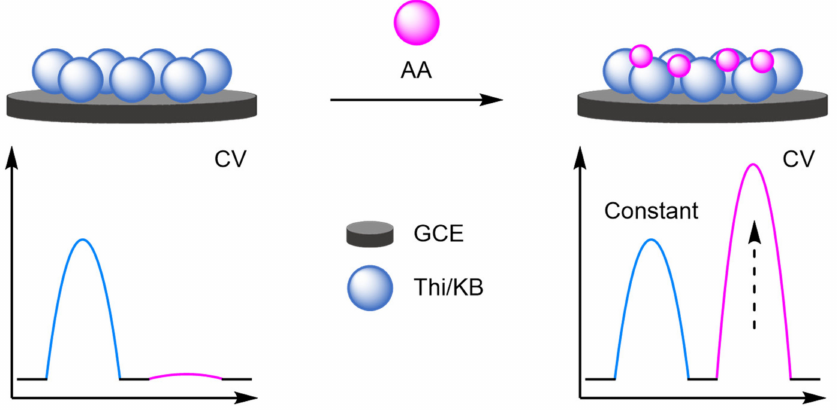
Figure 44. Schematic representation of Ketjen Black-based biosensor for the detection of ascorbic acid